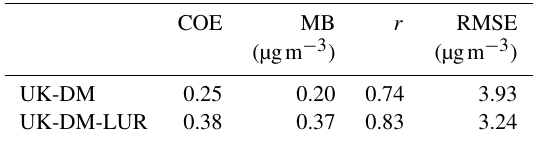
Table 4. Statistical results using the 12 monitoring stations after applying UK-DM and UK-DM-LUR directly to the annual averages in